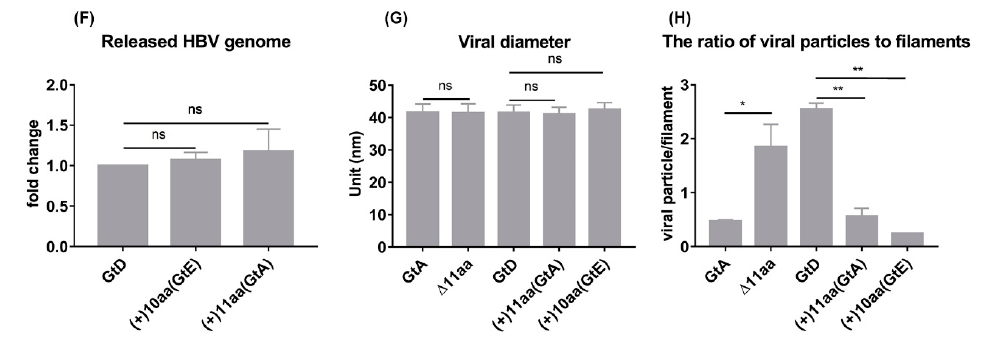
Figure 4. The presence of GtA-derived 11 aa promotes the generation of abundant longer filaments. ( A , B ) Polyethylene glycol (PEG)-concentrated supernatants from Huh7.5 cells overexpressing the genome GtA, GtD and the derivatives were analyzed by 10–30% ( w/w ) discontinuous sucrose gradient ultracentrifugation. A total of 24 fractions were harvested and fractions 10 to 24 were analyzed by refractive index, as well as Western blot using the PreS1-domain-specific monoclonal MA18/7. The signal of LHBs was measured by Image studio lite and the signal from fraction 24 was standardized as 1. ( C , D ) Filament-rich fractions (F20 in GtA, F17 in GtA_ ∆ 11aa, F15 in GtD, F21 in GtD_( + )11aa(GtA) and F18 in GtD_( + )10aa(GtE)) were analyzed by electron microscopy (EM). The size (diameter and length) of more than 80 filaments (101 in GtA, 136 in GtA_ ∆ 11aa, 87 in GtD, 108 in GtD_( + )11aa(GtA) and 81 in GtD_( + )10aa(GtE)) was measured by an EM-specific software Radius (EMSIS). ( E – H ) HBsAg-containing particles from Huh7.5 cells overexpressing GtA, GtD and the derivatives were precipitated by 10% PEG and then purified by sucrose ultracentrifugation followed by qPCR ( E , F ) and EM ( G , H ). (G) The diameter of more than 20 virions (47 in GtA, 92 in GtA_ ∆ 11aa, 90 in GtD, 42 in GtD_( + )11aa(GtA) and 22